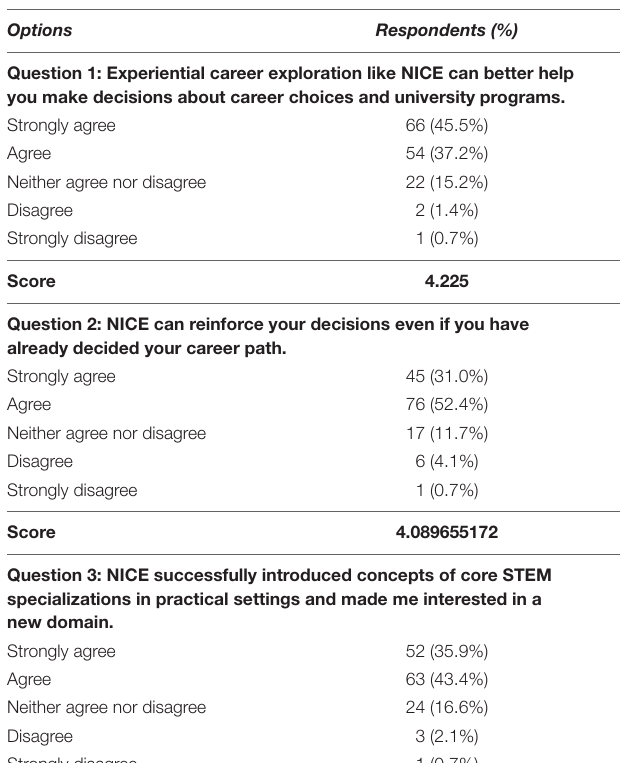
TABLE 1 | Distribution of survey responses and average scores for the three direct